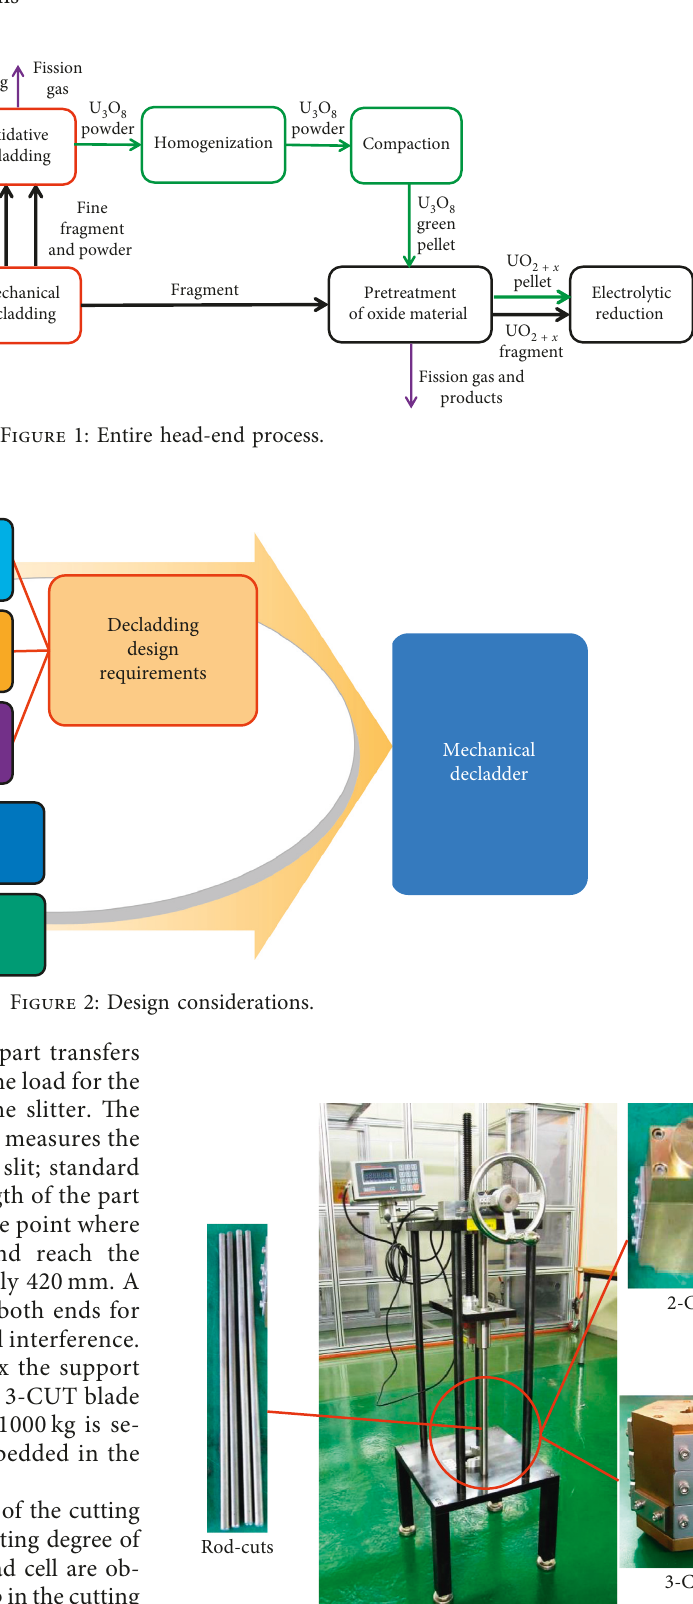
Figure 3: Slitter, 2-CUT and 3-CUT modules, and rod-cuts for slitting